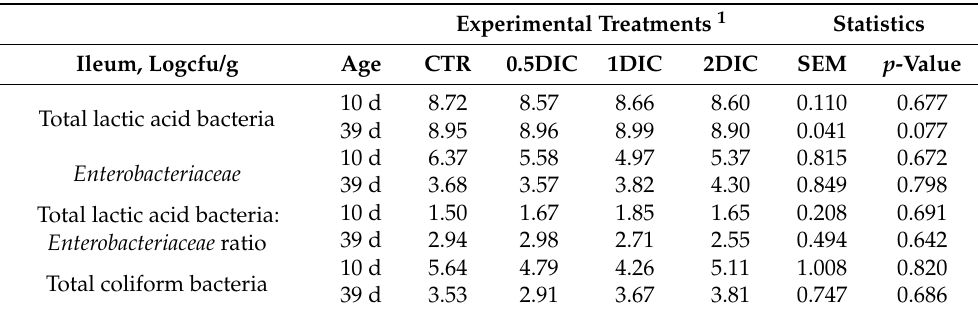
Table 5. Effects of dietary DIC supplementation level on ileal microbiological counts in 10-day-old and 39-day-old broiler chickens (Experiment 1).